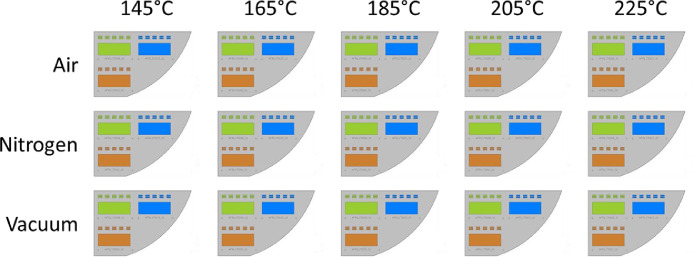
A graphical layout of the sintering scheme. Each substrate contains a sub-sample printed from each of the three inks, indicated by color.